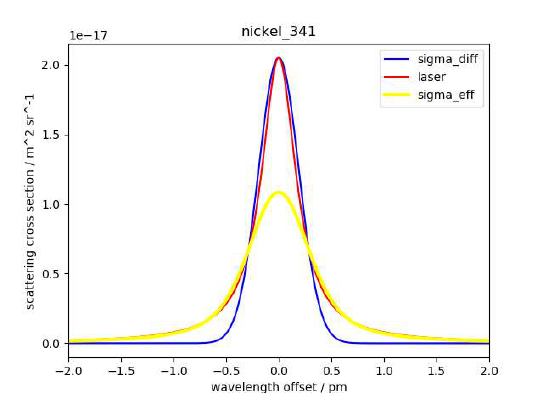
Fig. 1: Blue: Differential backscatter cross section for excitation of the low-lying excited Ni(3D) state. Red: Approximated laser spectrum (Lorentz-shape). Yellow: Effective differential backscatter cross section (convolution of laser and  diff) .